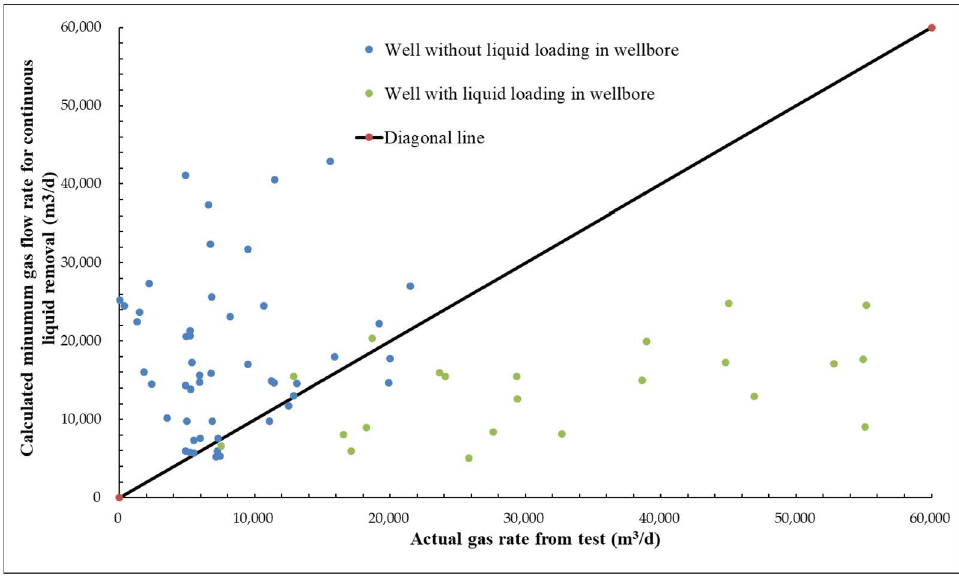
Figure 13. Calculated minimum gas flow rate under X = 2.8 versus actual gas well rate.